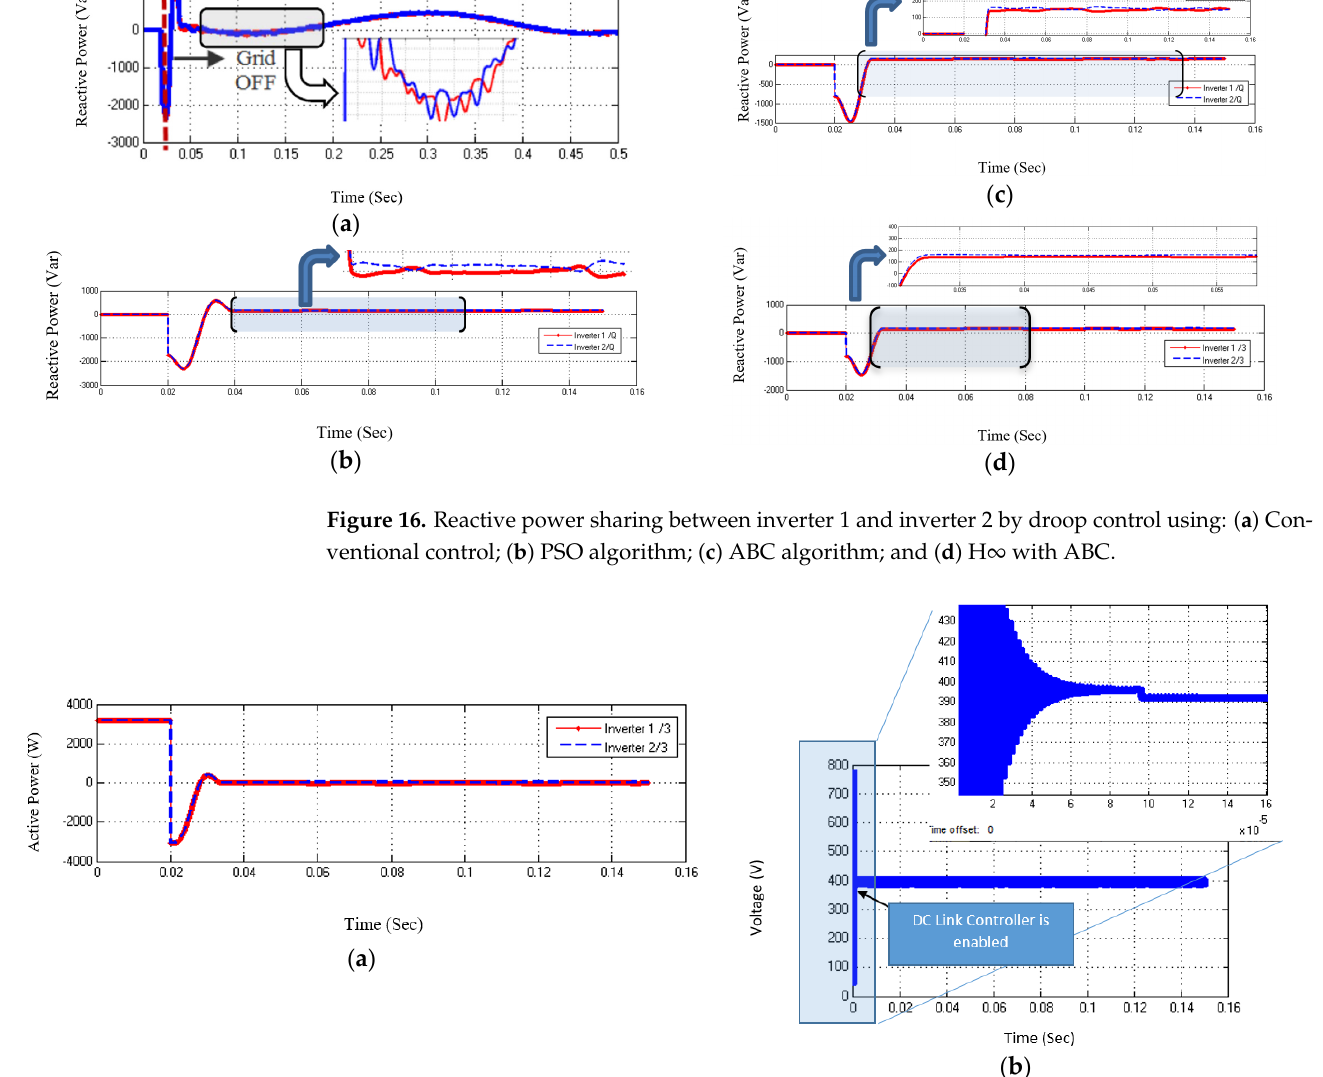
Table 4. Simulation parameters.